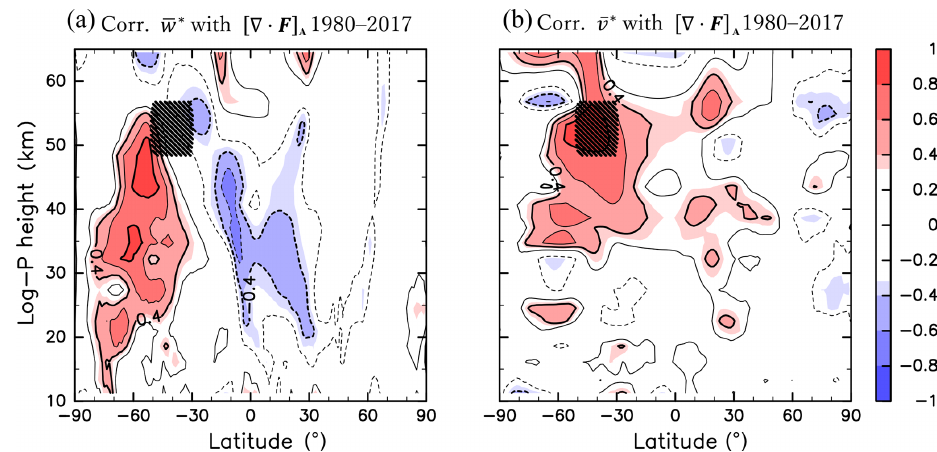
Figure 4. Same as Fig. 2 but for the correlations of [∇ · F ] A with (a) w ∗ (1980–2017) and (b) v ∗ (1980–2017).